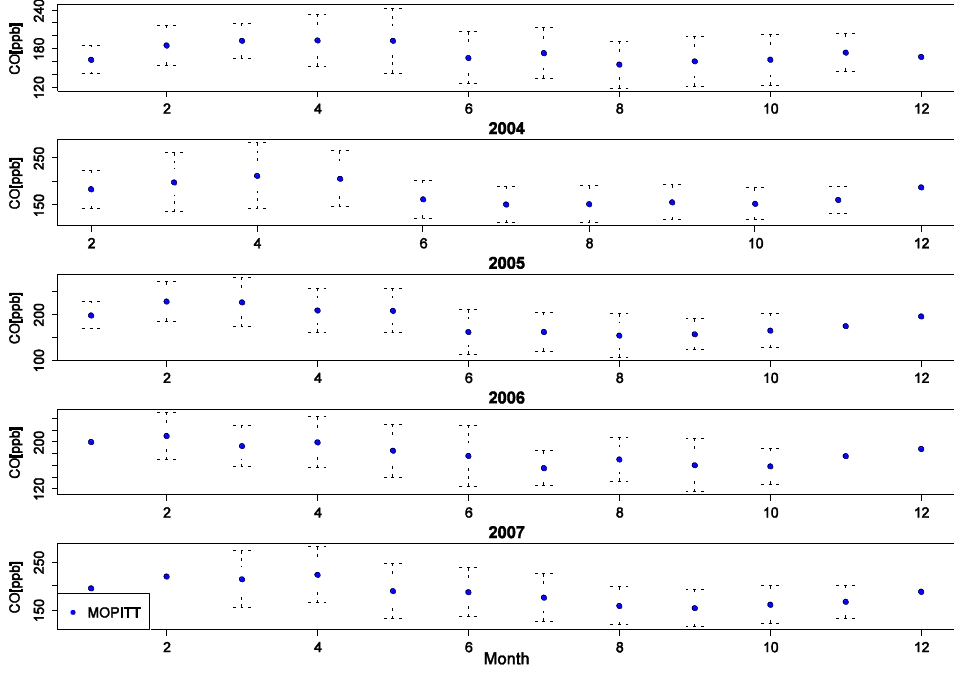
Figure 3. Monthly average CO from MOPITT retrievals (blue dot) along with their standard deviation (dashed lines). Retrievals with surface DFS < 0.4 where filtered out.